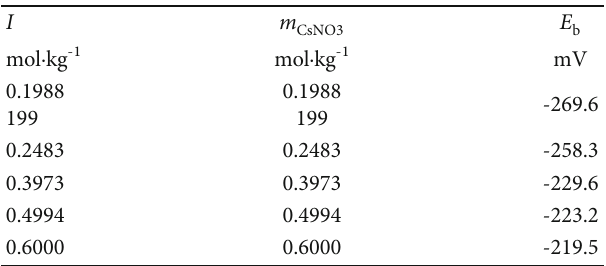
Figure 1: The response line of Na-ISE and NO Table 3: Electromotive force values of CsNO concentrations a .